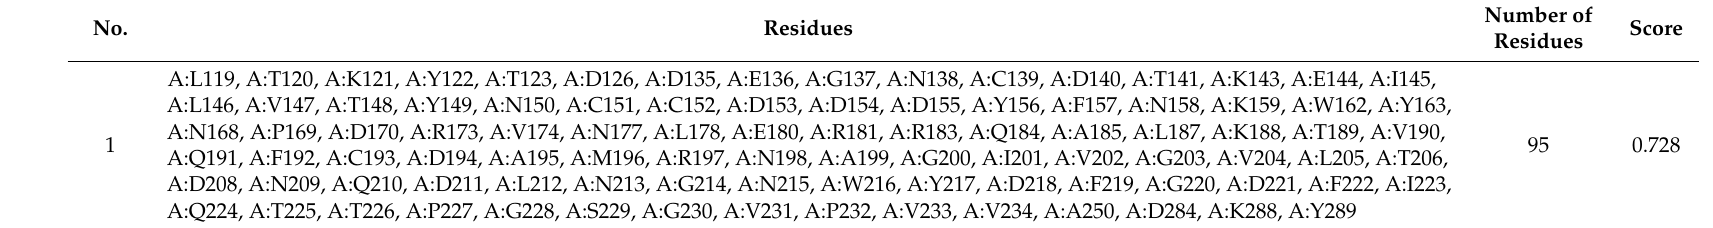
Table 10. Conformational epitopes of SARS-CoV-2 S